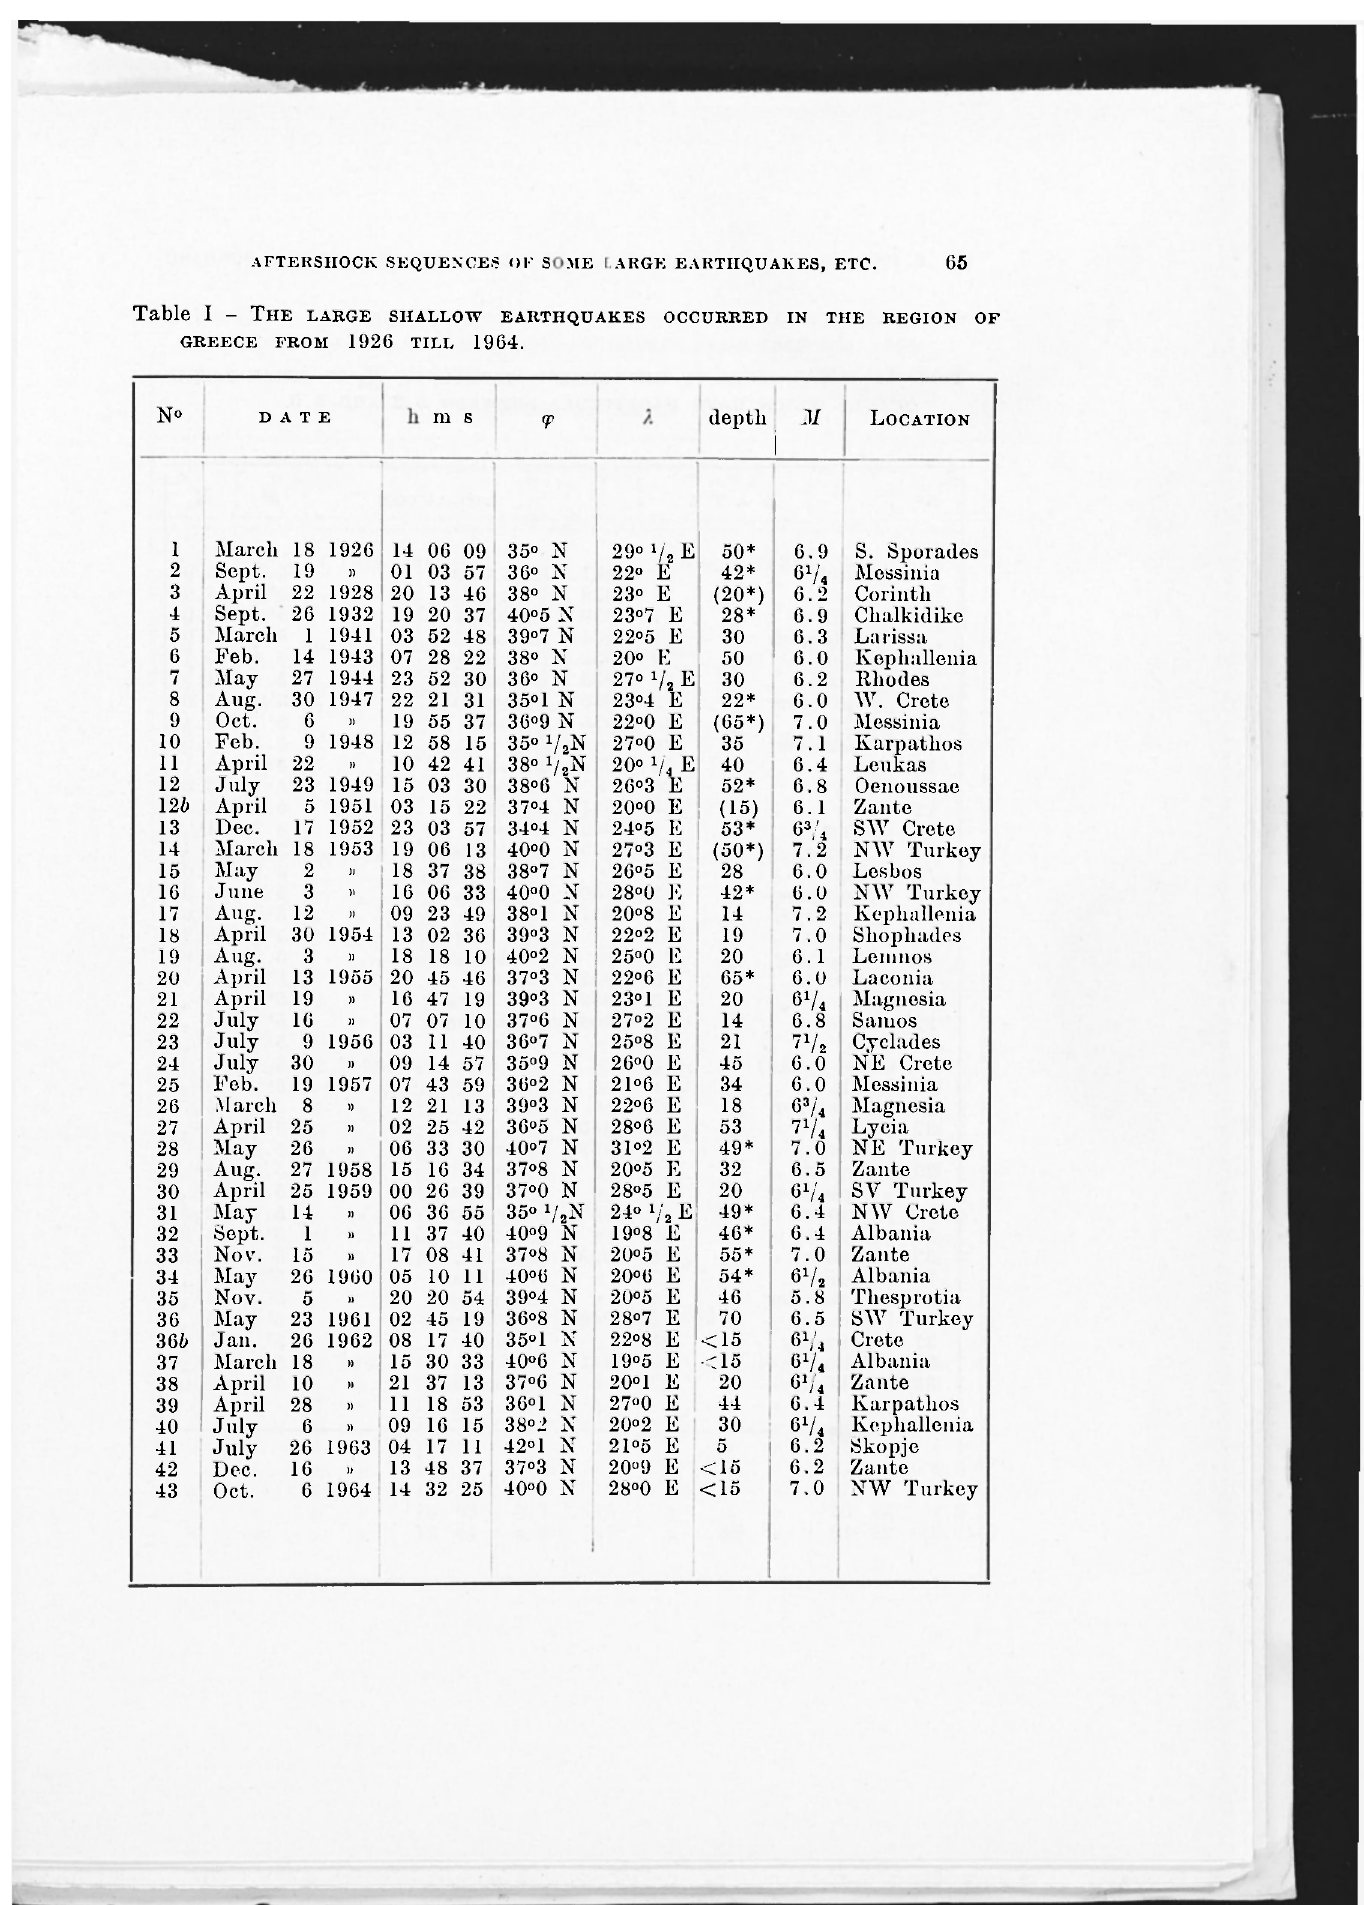
Table I - THE LARGE SHALLOW EARTHQUAKES OCCURRED IN THE REGION OF GREECE FROM 1926 TILL